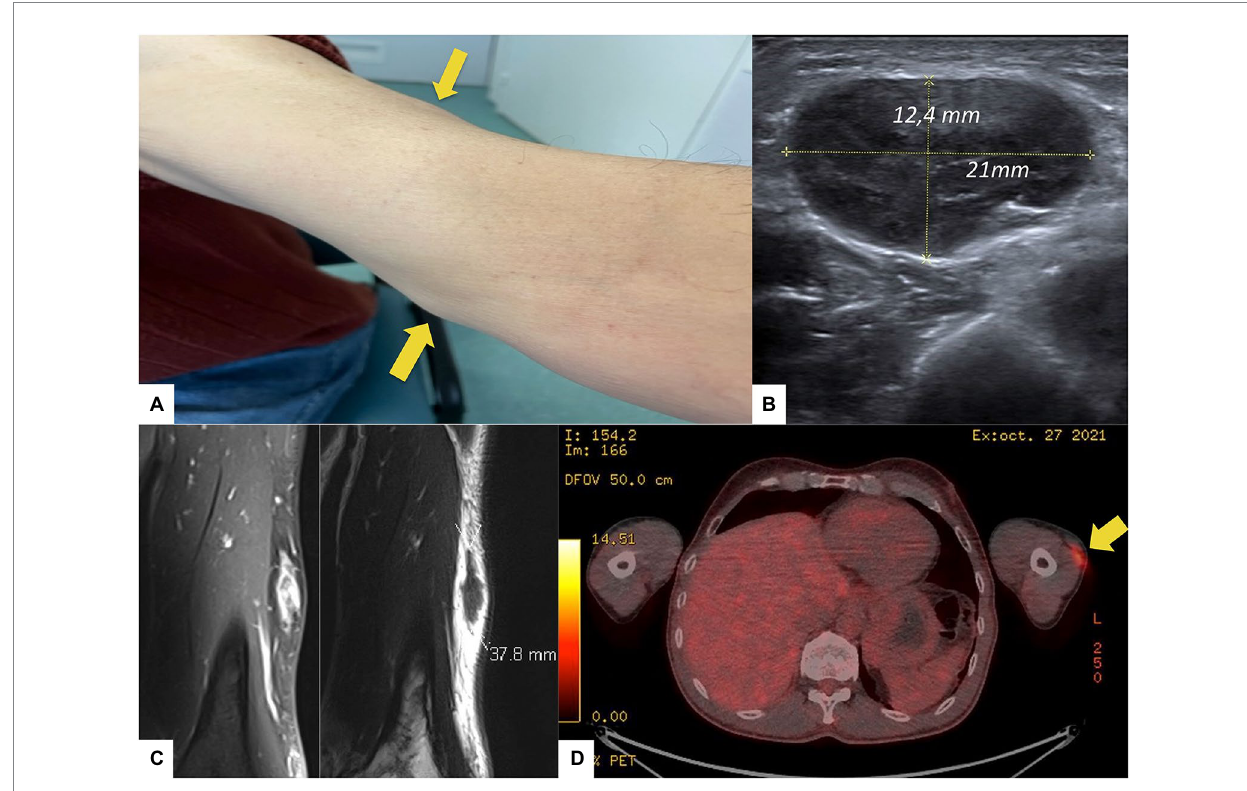
FIGURE 1 Clinical and paraclinical features of the patient. (A) Presence of two subcutaneous nodules on the left arm (arrows), (B) Soft tissue ultrasound of the left arm evidencing and measuring one subcutaneous mass, (C) MRI frontal slices of the left upper limb (T1 with gadolinium injection on the left, and T2 on the right), and (D) 18-FDG-PET-CT scan showing a 18-FDG uptake by the nodule (arrow) on the left